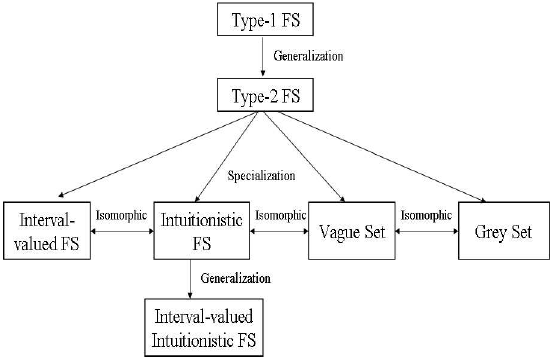
Fig. 2. Some extensions of